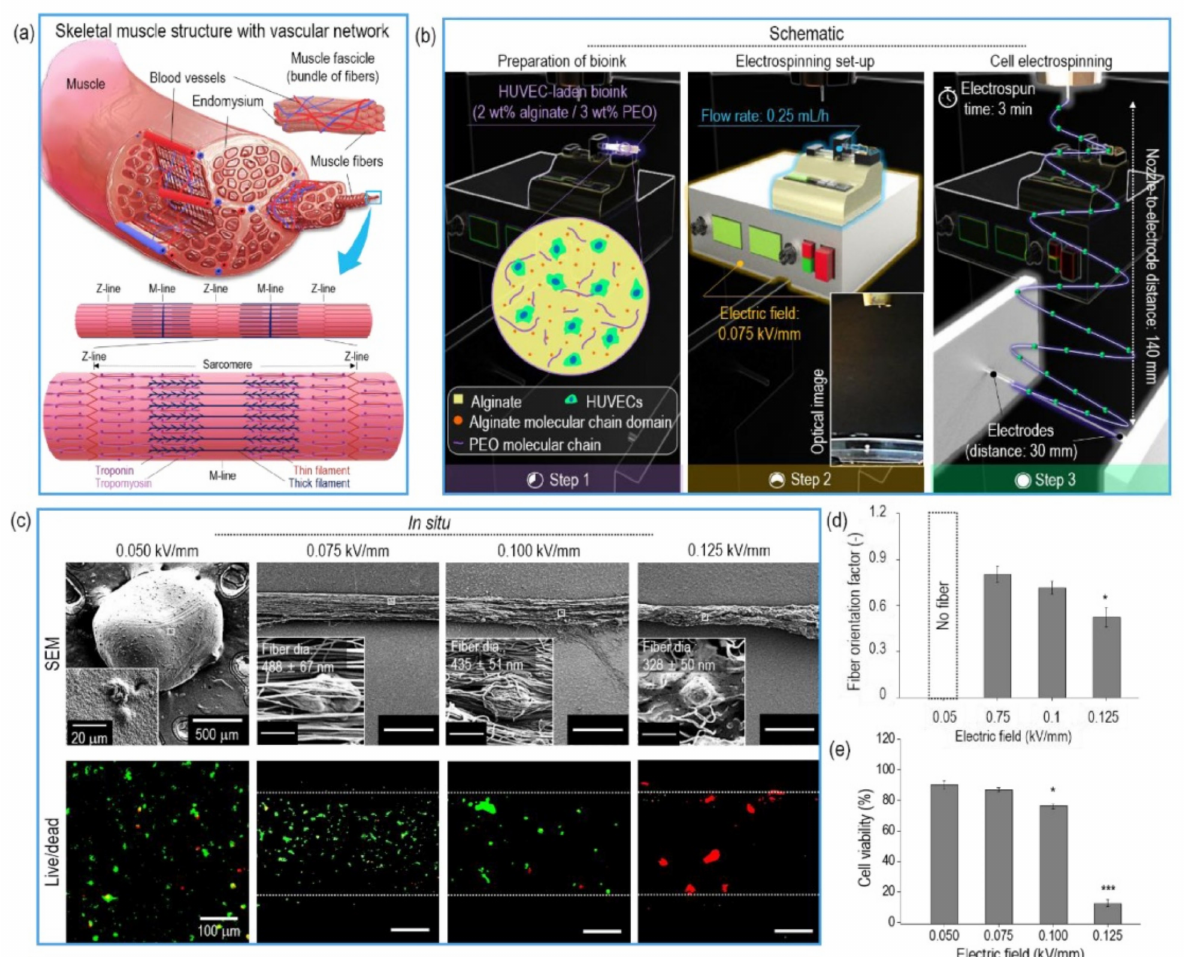
Figure 3. Schematics of ( a ) a native skeletal muscle structure with a vascular network and ( b ) the cell electrospinning process using human umbilical vein endothelial cells (HUVECs). ( c ) SEM and live/dead images of HUVECs-laden fibers fabricated using various electric fields. A quantitative analysis of ( d ) orientation factor of nanofibers and ( e ) cell viability where the analysis of variance (ANOVA) was used for the multiple comparisons and p * < 0.05, p ** < 0.01, and p *** < 0.001 indicate the statistical significance. Adapted from [115] with permission from